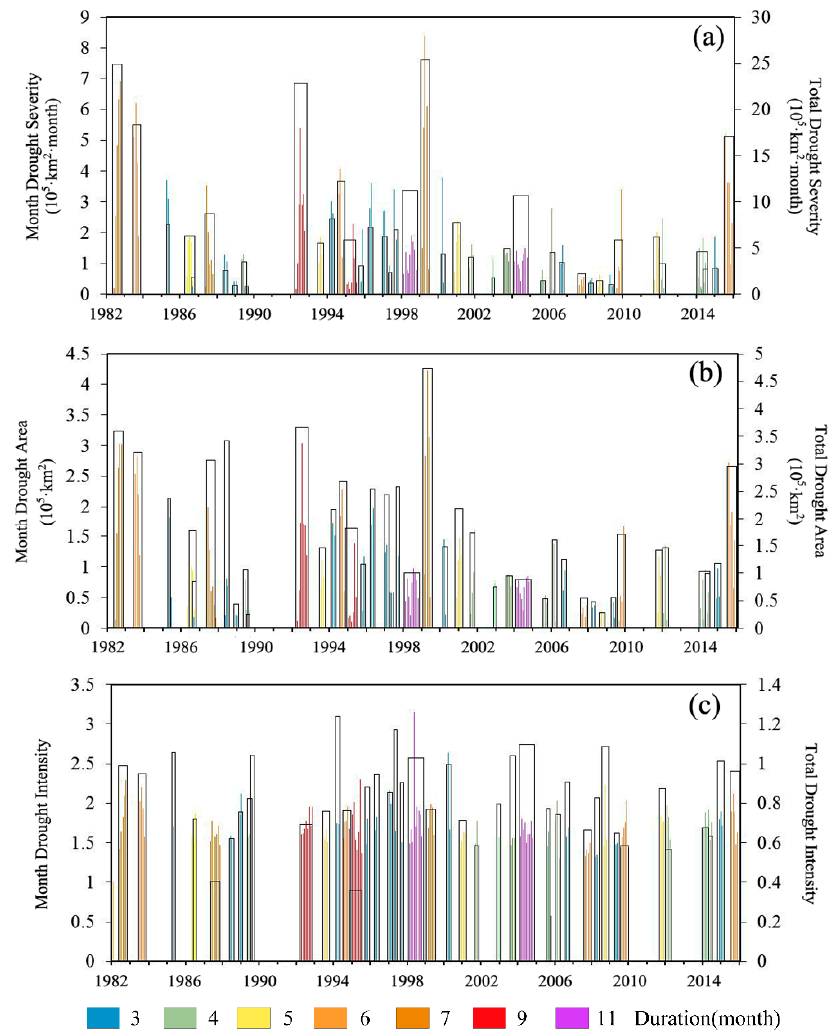
Figure 3. Temporal evolution of the stepwise monthly severity ( a ), stepwise monthly area ( b ), and stepwise monthly intensity ( c ) for 44 drought events that occurred between 1982 and 2015.